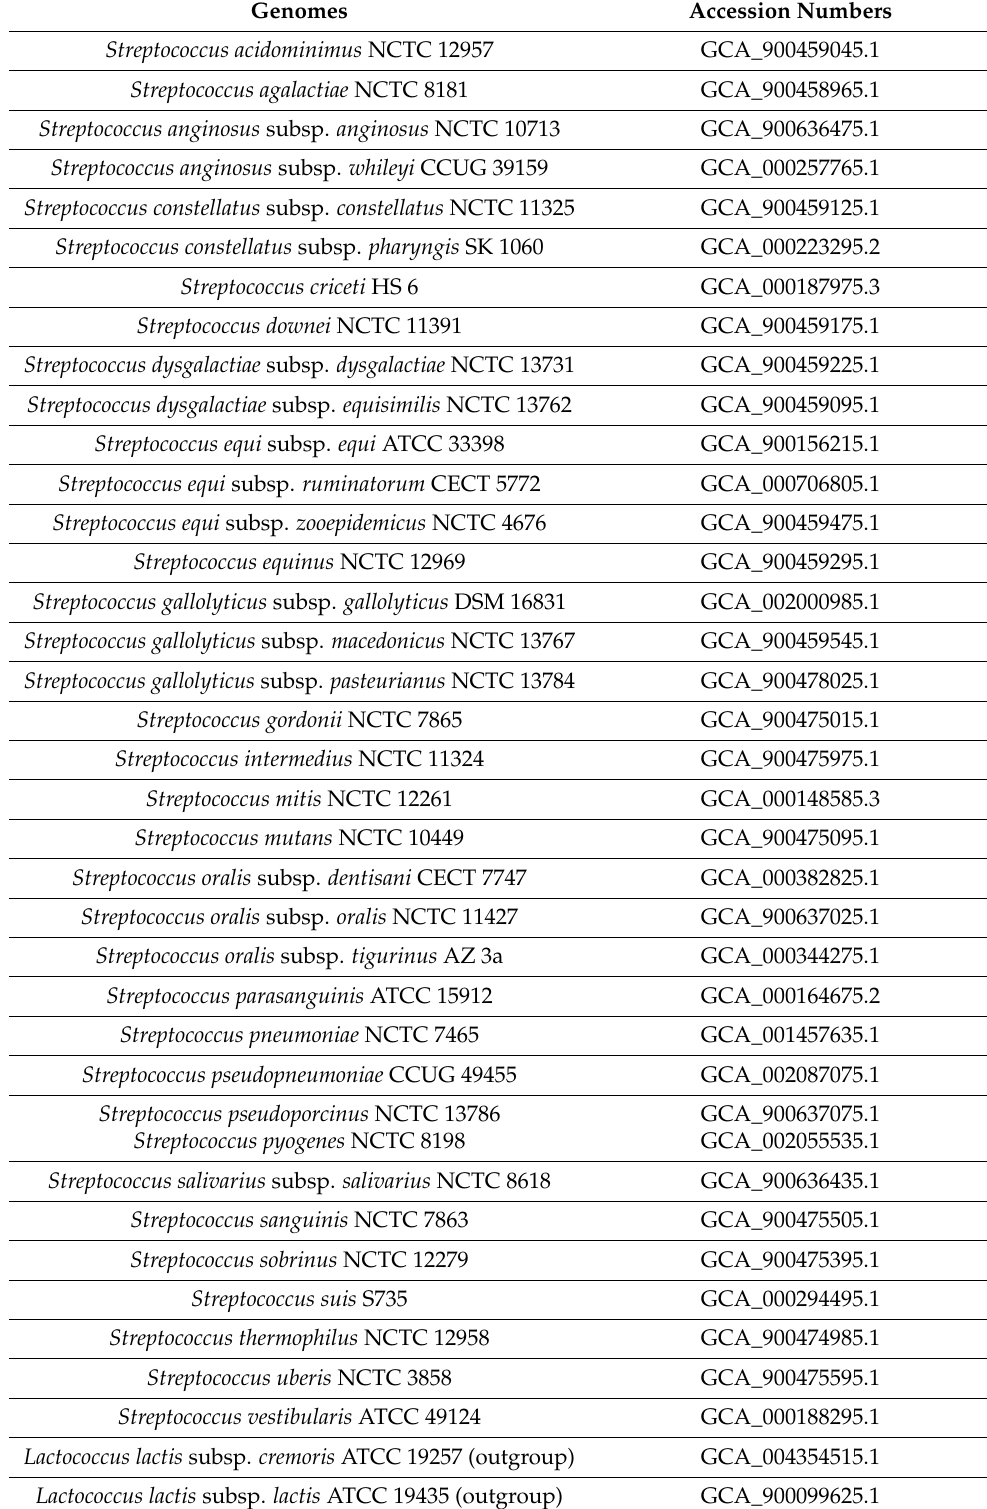
Table 2. Genomes used in the phylogenetic analysis and their respective NCBI accession